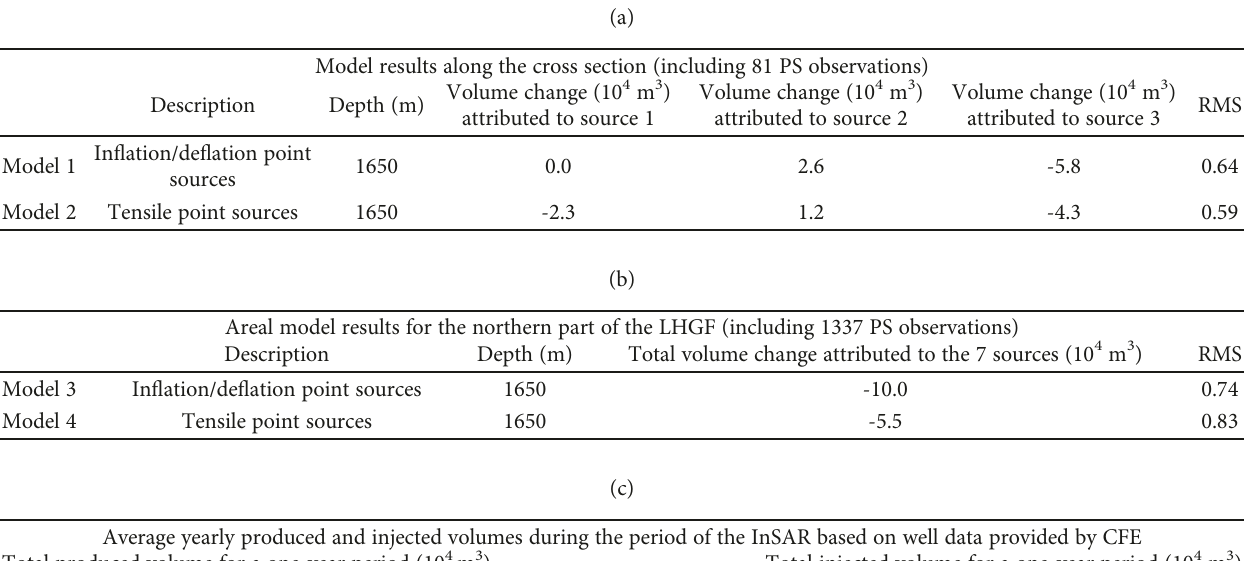
Table 2: Description of the models, the best- fi tting volume changes attributed to the sources, and the average yearly produced and injected volumes. Note that the volume changes are reported for the period of one